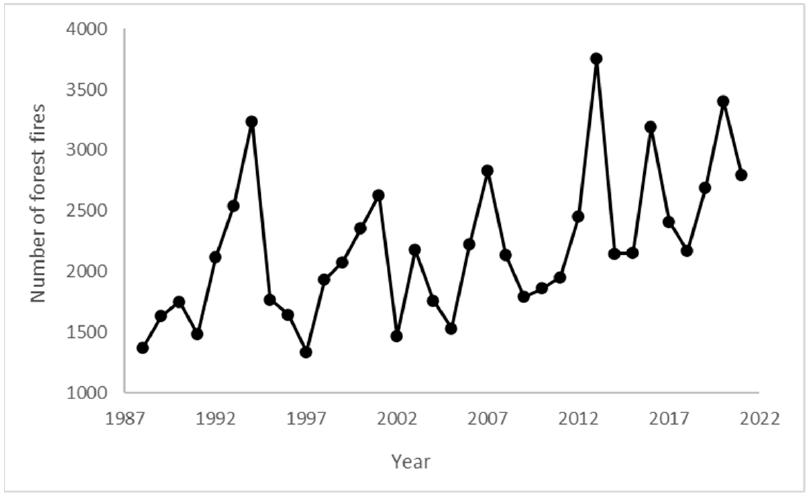
Figure 2. Number of fi res in Turkey (1988–2021).